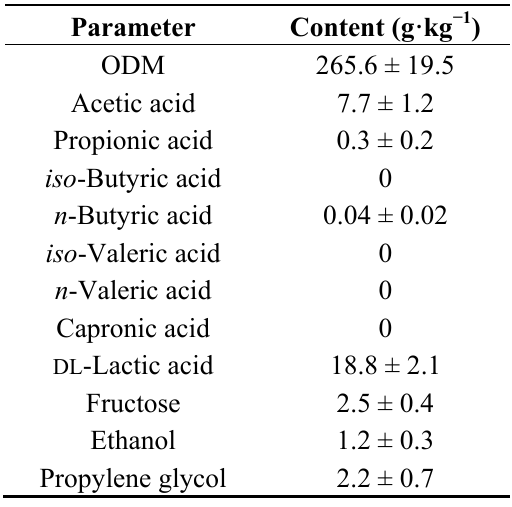
Table 1. Chemical characteristics of the maize